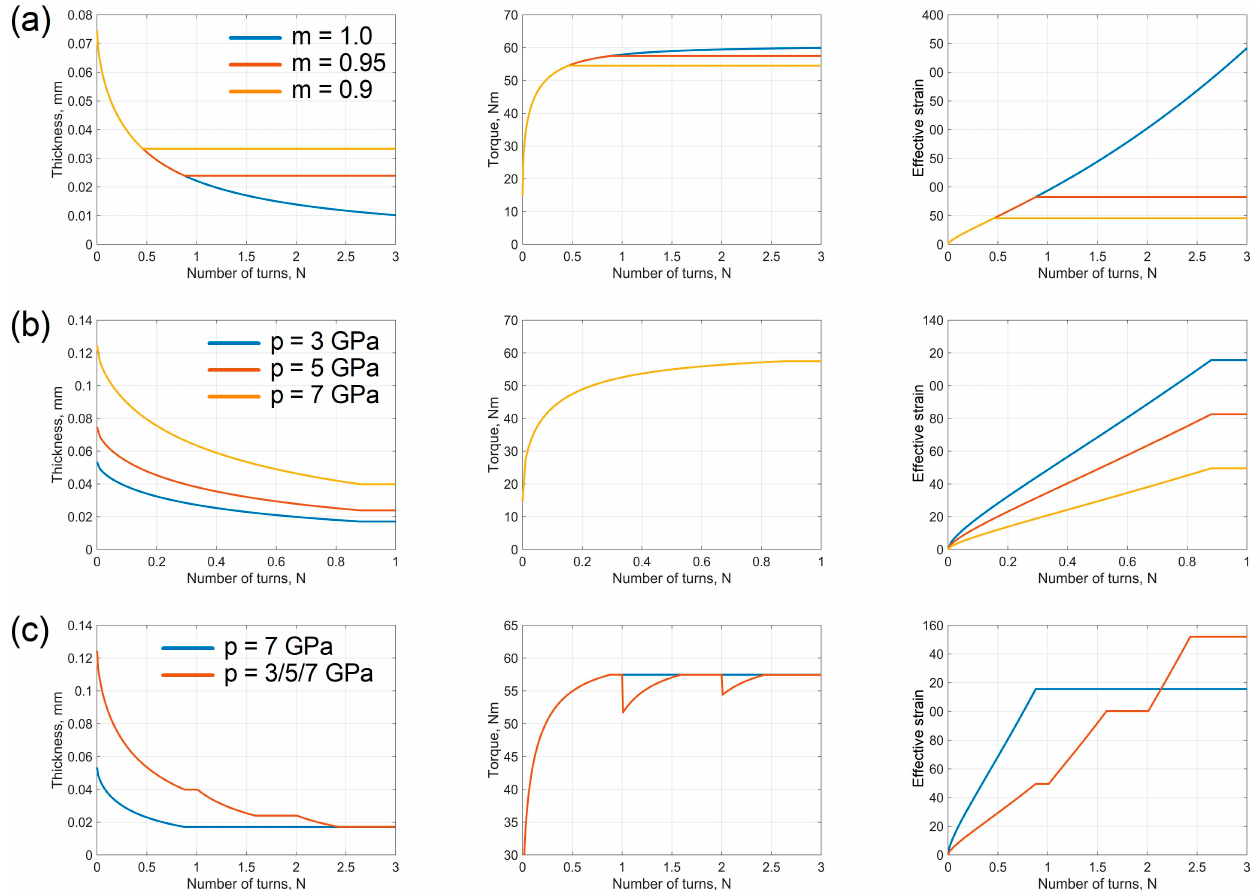
Figure 4. The dependence of the specimen thickness, torque, and effective strain on the number of anvil revolutions according to the model presented ( a ) at a fixed axial pressure of 5 GPa ; ( b ) at a fixed friction factor of m = 0.95 ; ( c ) the effect of the loading schedule.